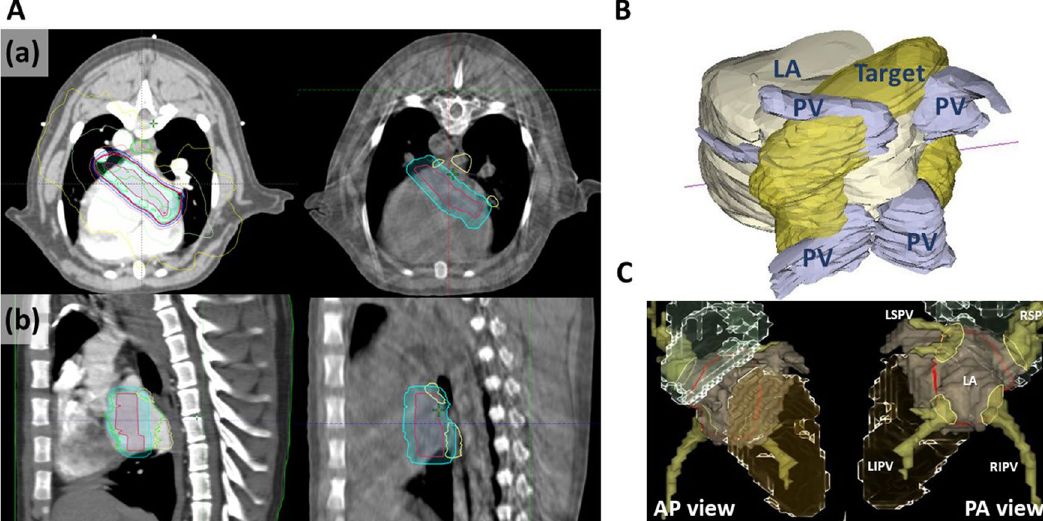
Figure 1. Radiotherapy design. ( A ) Axial (a) and sagittal (b) views of simulation CT with dose distribution with isodose lines (left), and cone beam CT for set-up verification (right). Red, target; cyan, planned target volume (PTV); yellow, pulmonary veins; light green, left atrium. ( B ) Posterolateral view of 3D reconstructed contoured target. ( C ) Three- dimensional reconstruction images from PA and AP views using CARTO-3 mapping system. The red line indicates the border of circular box lesion. CT computed tomography, LA left atrium, PV pulmonary vein, LSPV left superior pulmonary vein, RSPV right superior pulmonary vein, LIPV left inferior pulmonary vein, RIPV right inferior pulmonary